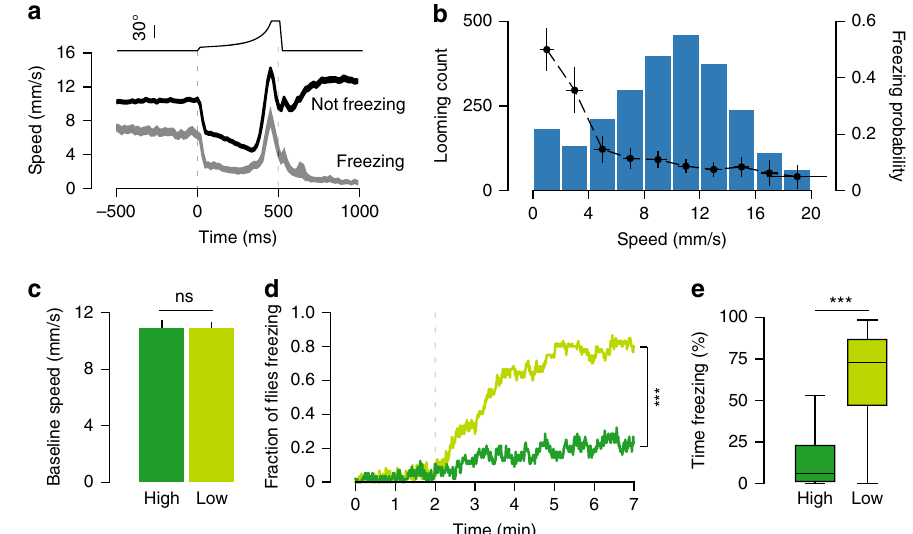
Fig. 4 Response to looming is modulated by walking speed. a Looming-triggered speed pro fi le (average ± s.e.m.) including only transition trials where fl ies were not freezing before the stimulus ( n = 2501 loomings), separated into events that led to freezing (light gray, n = 346) and events that did not (dark gray, n = 2155). b Distribution of fl y speed 500 ms before loomings where fl ies were not freezing (blue bars, n = 2501 loomings) overlaid with the probability of freezing after the stimulus for each speed interval (black dots and trace). X-error bars shows standard deviation (s.d.) for speed sampled within each interval and Y-error bars show 95% con fi dence intervals (CI). a , b Show data from the experiment in Figs. 1 – 3, whereas panels c – e show data from closed-loop experiments. In c – e , dark green corresponds to high speed ( n = 56) group and light green to low speed group ( n = 60). c Average + s.e. m. speed during baseline period for high and low speed groups. d Proportion of freezing fl ies. Dashed line indicates onset of stimulation. e Percent time spent freezing during stimulation period. *** denotes p < 0.001, ns not signi fi cant. Box plot elements: center line, median; box limits, upper (75) and